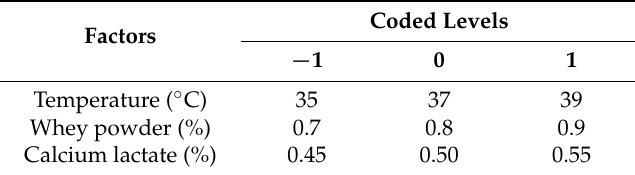
Table 1. The factors level coding table of Box–Behnken for incubation conditions of